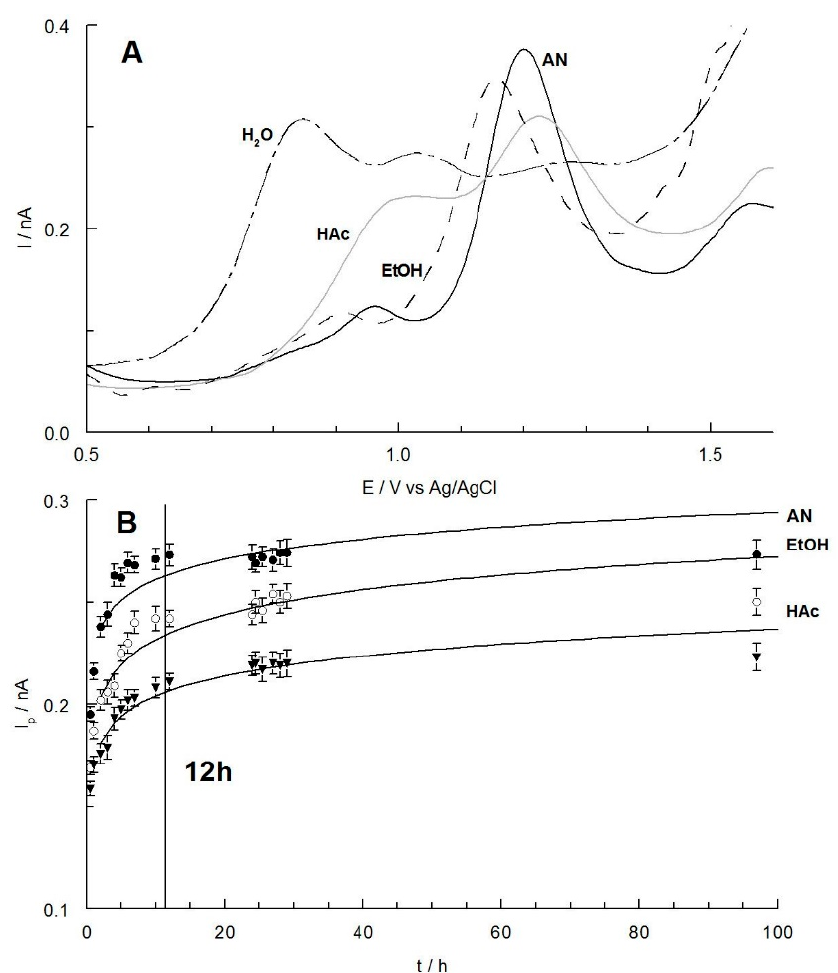
Figure 3. ( A ) Differential pulse voltammetry (DPV) curves of isopropylmethylphenols oxidation recorded in solutions containing thyme extracts (70 µL extract/mL, commercial spice) in selected solvents after 12 h of extraction. ( B ) Influence of the extraction time on the DPV peak current ( I p ) of the THY and CAR oxidation. Other components of the solutions as in Figure